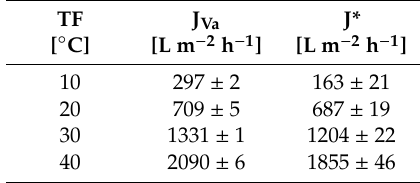
Table 1. Effect of temperature (TF) on the mean values and standard deviations of the average (J Va ) and limiting (J*) permeation fluxes across 1.4- μ m ceramic hollow-fiber (HF) membrane module when using Brewers Clarex ® (BC)-treated and centrifuged rough beer with H P ≈ 2 European Brewery Convention unit (EBC-U).